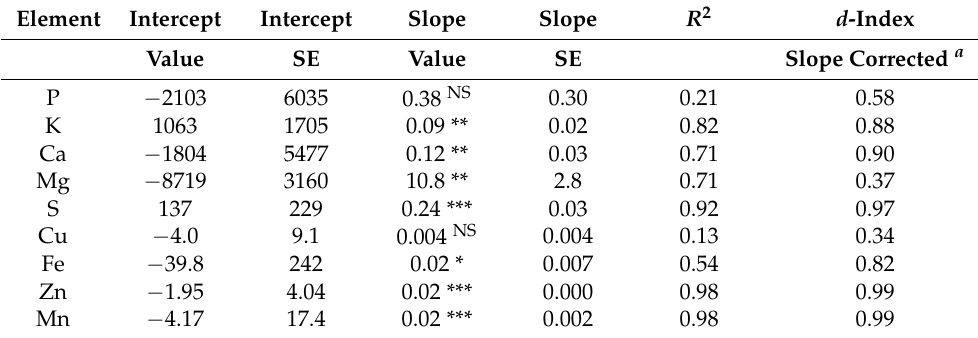
Table 3. Intercept, slope, coefficient of determination ( R 2 ), and d-index of linear regression between values determined by pXRF intensity (net intensity) and ICP-AES (concentrations in mg kg − 1 ). Results are from the ‘modeling’